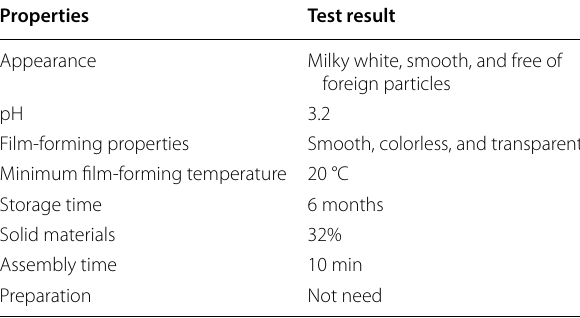
Table 1 The characteristics of the polyvinyl acetate